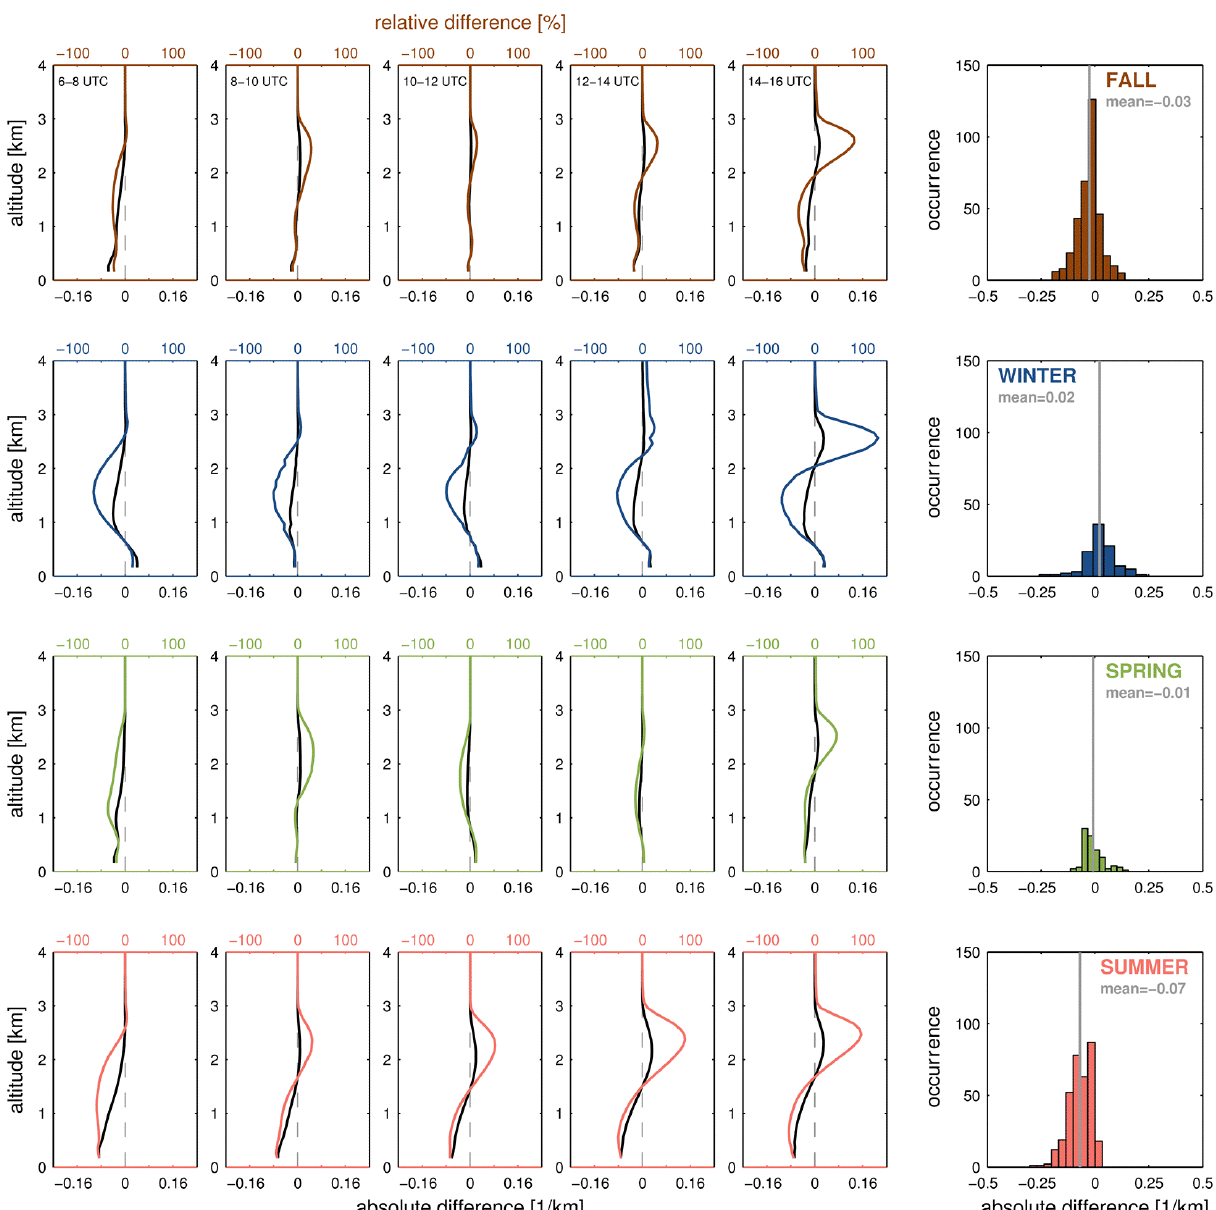
Figure 8. Same as Fig. 7 but for the visible channel (MAX-DOAS: 425–490nm, ceilometer: